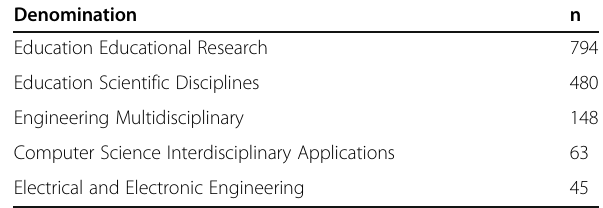
Table 3 Areas of